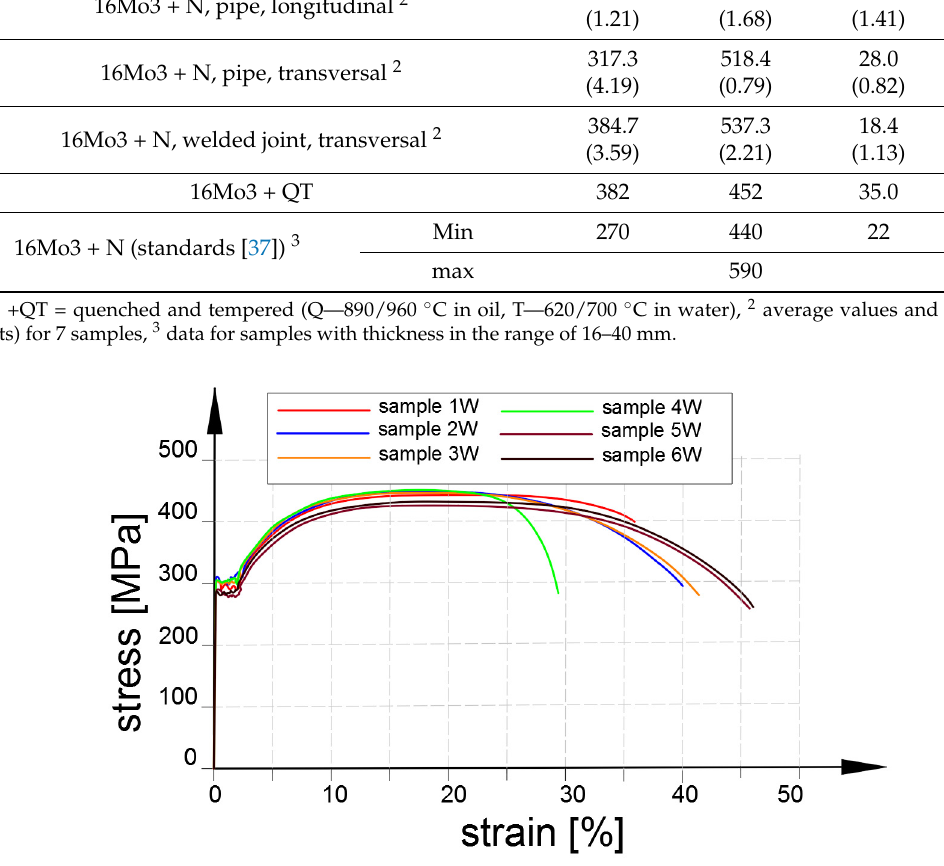
Figure A1. Engineering stress—strain curves for 16Mo3 + N alloy steel. Samples were cut from flat end in longitudinal direction (set 1a).